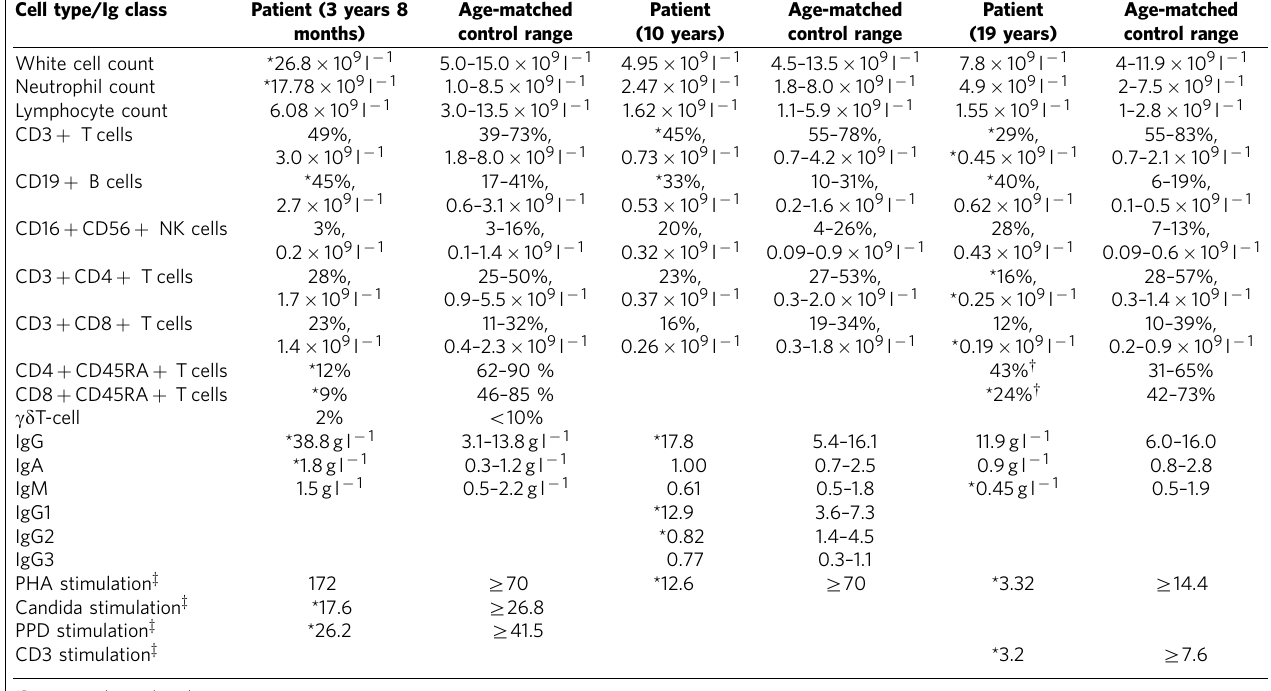
Table 1 | Immunological